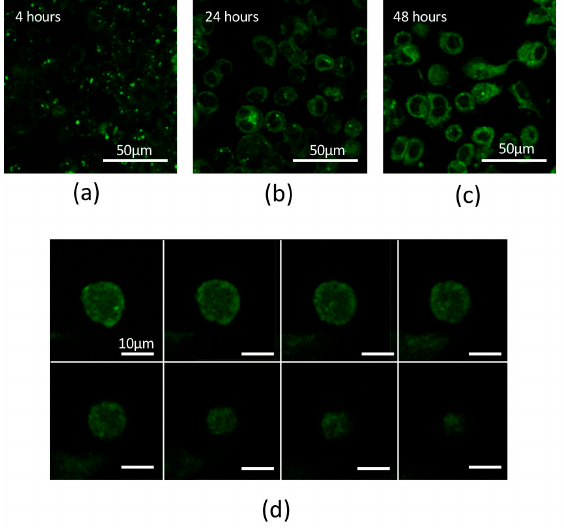
Figure 3. ( a ) Confocal laser scanning microscopy (LSM) image showing strong Alexa 488 fluorescence intensity on the surface of SK-BR3 cells. PCSN probes were bound to the surface of SK-BR3 cells within 4 h. ( b ) LSM image showing strong fluorescence signals inside the SKBR3 cells. PCSN probes were internalized into the cytoplasm during a 24-h incubation in medium containing targeted PCSN probes (1200 ppm). ( c ) PCSN probes remained inside the SK-BR3 cells after 48 h. ( d ) For three-dimensional analysis of the SK-BR3 cells, images were collected at 0.41-µm intervals with a 488-nm laser to create a Z stack. The images show internalized PCSN probes inside an SK-BR3 cell.